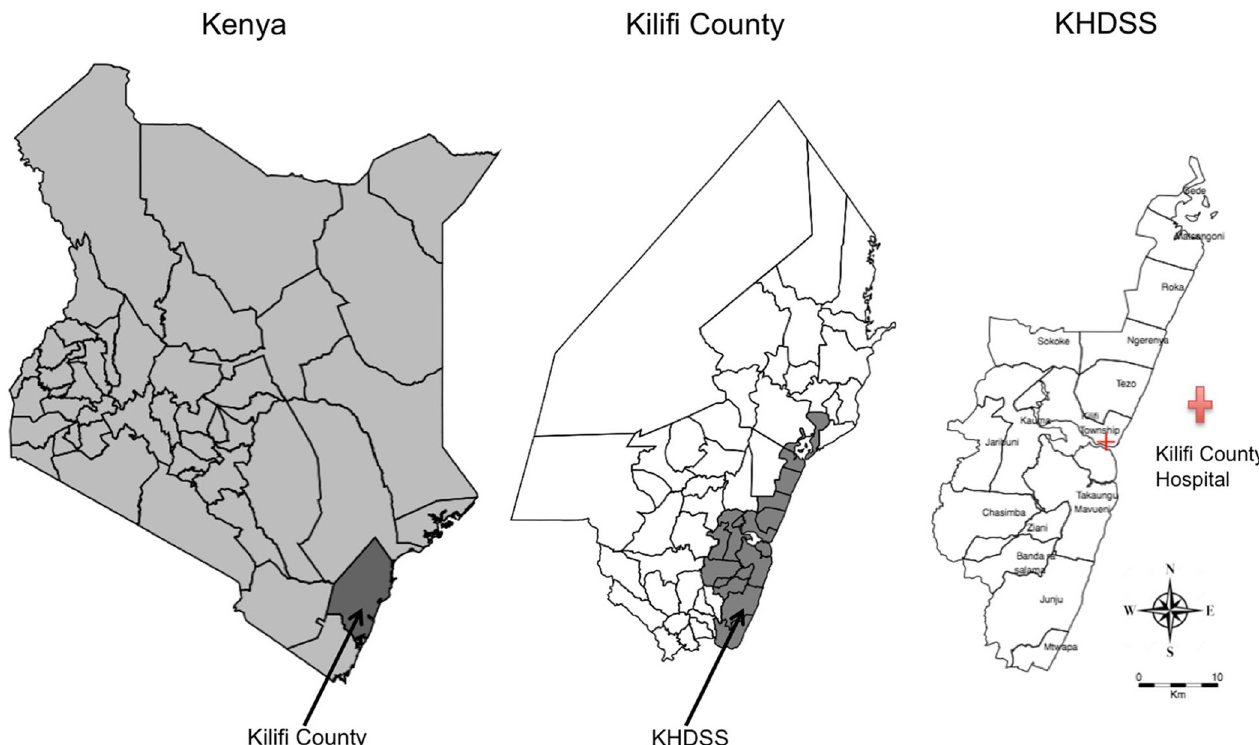
Fig 1. Geographical location of the study area. Left: Location of Kilifi county in Kenya. Middle: Map of Kilifi county showing KHDSS boundaries. Right: KHDSS map showing Kilifi County Hospital location. Reprinted from [27] under a CC BY license, with permission from BioMed Central, Alice Kamau (original copyright owner)